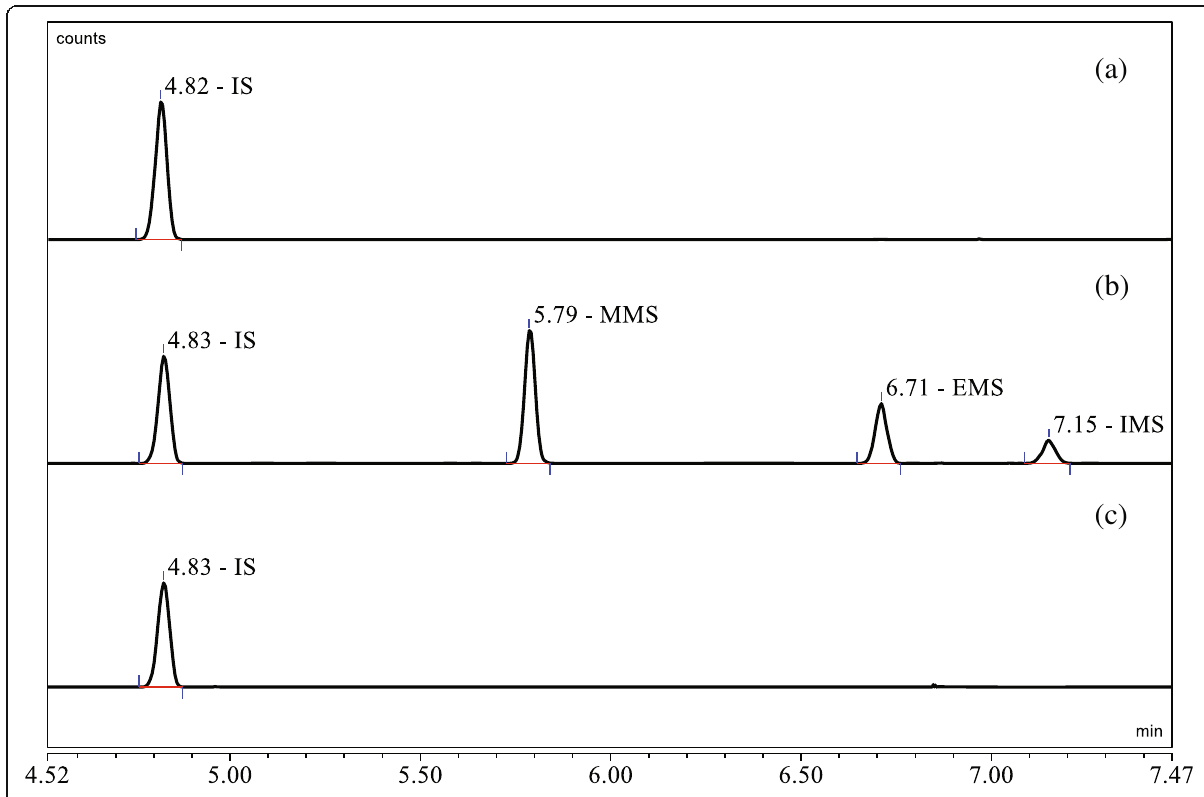
Fig. 3 Representative total ion chromatograms of a extraction solvent with IS, b standard solution, and c test solution on Rtx-624